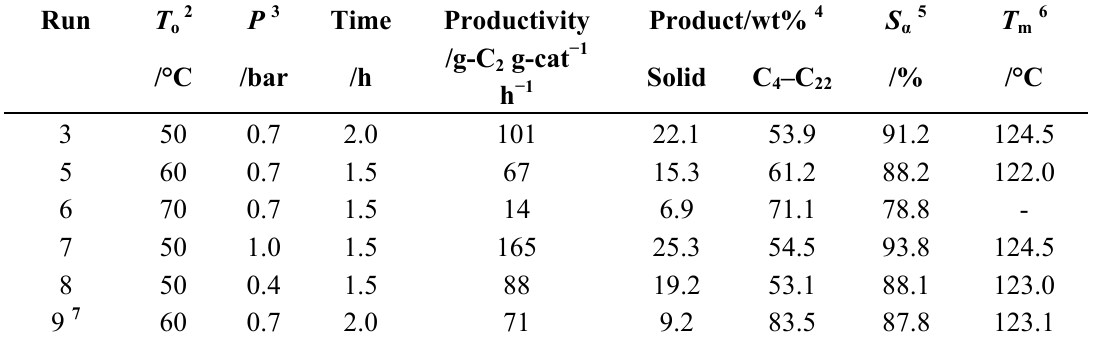
Table 2. The results of ethylene oligomerization using L3 /Ni 2+ -Mica under various reaction conditions 1